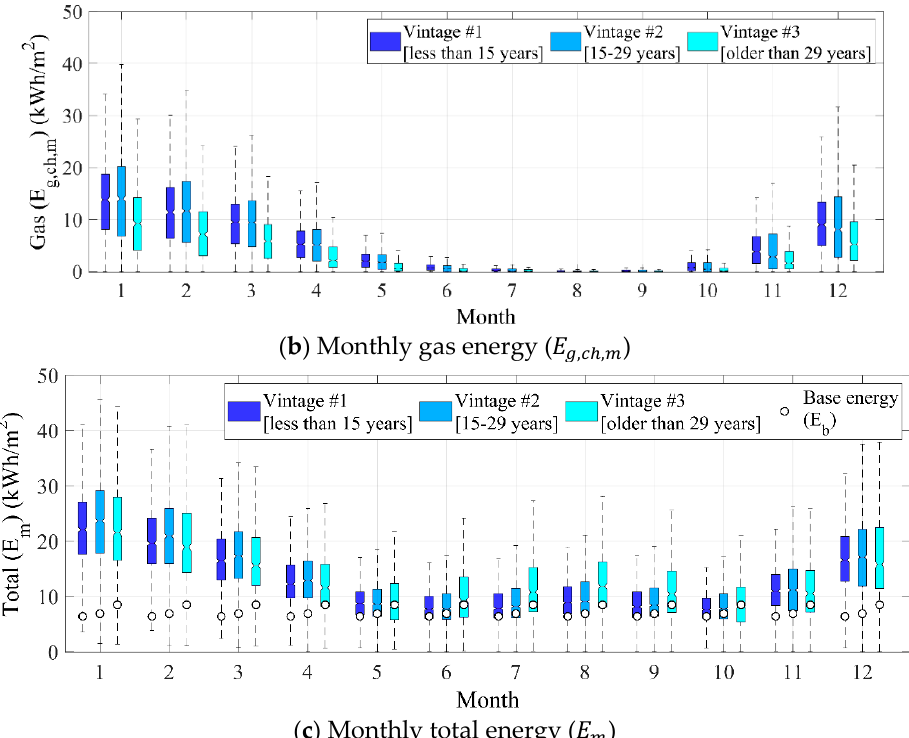
Figure 8. Boxplots showing the monthly ( a ) electric energy consumption ( E e , ch , m ), ( b ) gas energy consumption ( E g , ch , m ), and ( c ) total energy consumption ( E m ) of buildings predominantly cooled using electric chillers (n = 3908). (Boxplot in MATLAB was used).